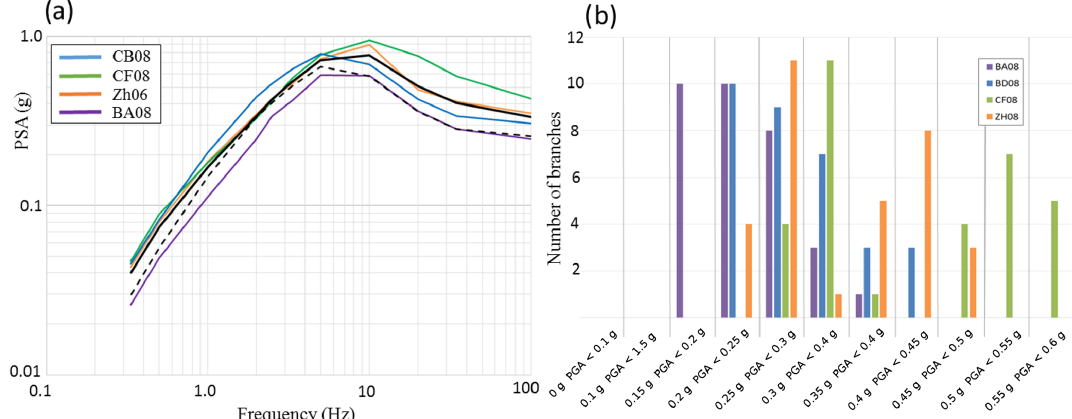
Figure 2. (a) Mean UHS for each GMPE for a return period of 10000 years (see Table 3 for the description of each GMPE). The black line is the mean of the four GMPEs. The dotted black line is the UHS of the branch used for the sensitivity analysis (see text for detail). (b) Dispersion of PGA at 10000 for each GMPE branch resulting from the exploration of epistemic uncertainties shown in Fig. 1.